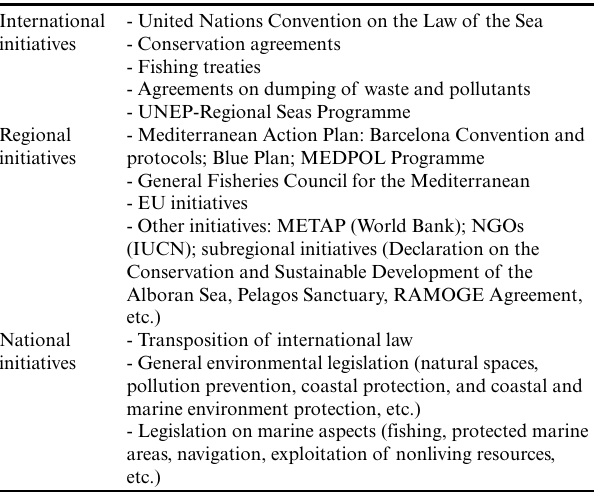
Table 1 . Legal-institutional marine governance forms in the Mediterranean that involve both EU and non-EU countries (Suárez de Vivero and Rodríguez Mateo